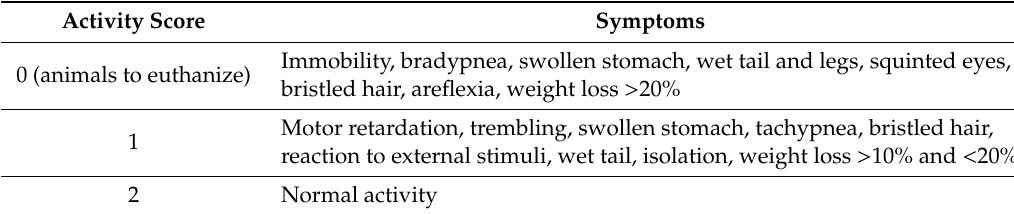
Table 1. Clinical activity